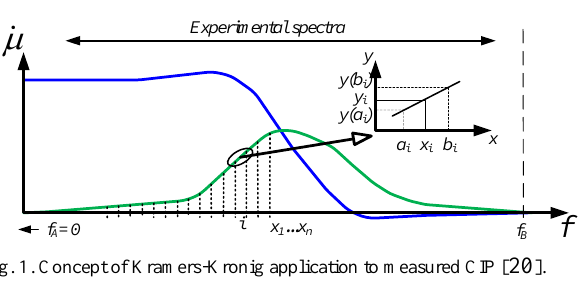
Fig. 1. Concept of Kramers-Kronig application to measured CIP [ 20 ].